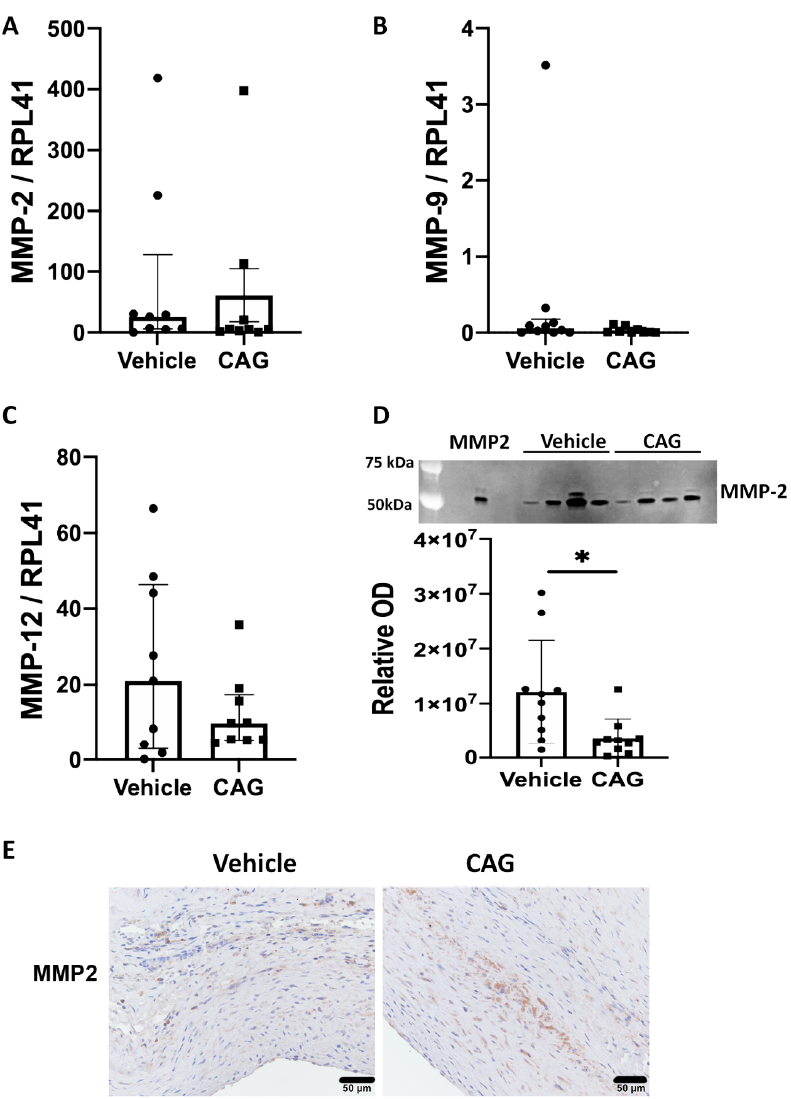
Figure 4. Quantity and activity of matrix metalloproteinases (MMPs) in AAAs. Assessment of messenger RNA (mRNA) from aneurysmal wall samples from vehicle and CAG group coding for ( A ) MMP-2 (n = 9/9), ( B ) MMP-9 (n = 9/9), and ( C ) MMP-12 (n = 9/9). ( D ) Zymography and quantification of zymography showing significantly increased activity of MMP-2 in vehicle compared to CAG group (n = 10/10; p = 0.02). ( E ) Displays weak MMP-2 labeling in a subset of vascular smooth muscle cells of the aneurysm wall from both vehicle- and CAG-treated rats (n = 8/7), scalebar = 50 µm. Values in ( A – C ) are median ± interquartile range and normalized to RPL41 mRNA levels. Values in ( D ) are mean ± SD, * indicates p = 0.02.